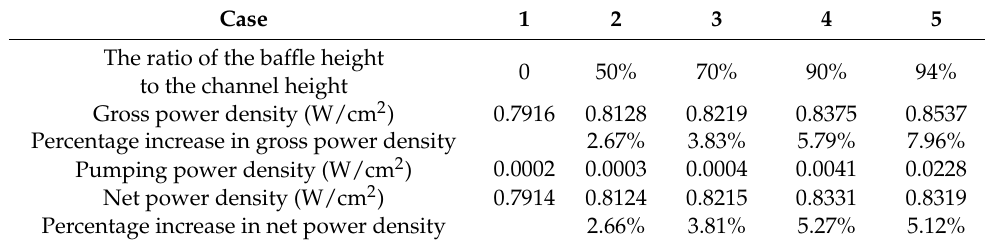
Table 5. Cases performance under different dimensionless heights of baffles.